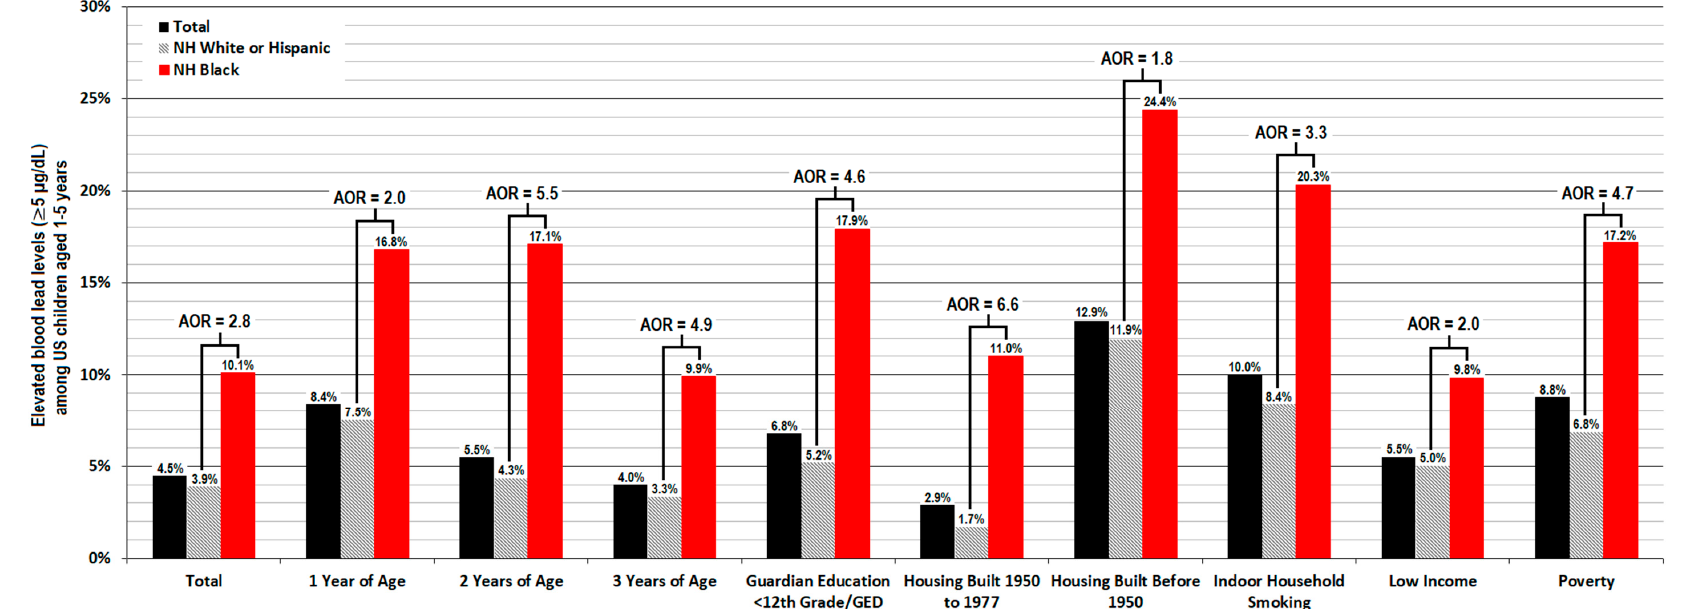
Figure 3. Weighted estimates of means and adjusted odds ratios (AORs) for rates of an elevated blood lead level (EBLL) ≥ 5 µg/dL within the general US population or risk factor groups among children 1–5 years of age with US citizenship—the 1999 to 2010 NHANES.